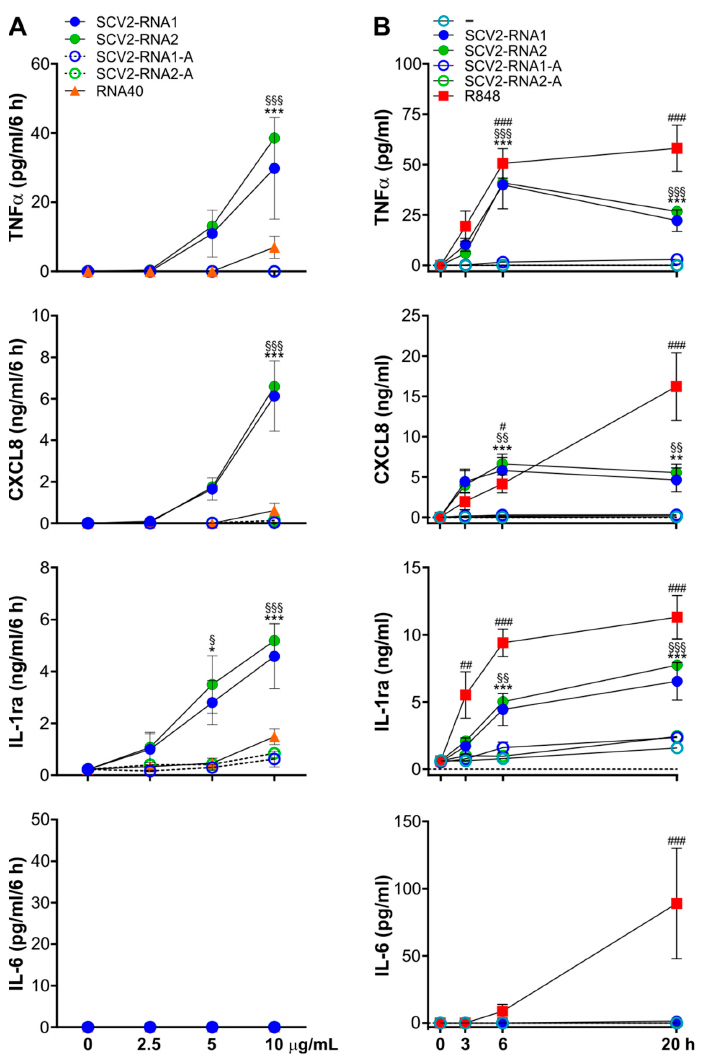
Figure 1. Cytokines production in neutrophils stimulated by SCV2-RNA1 and SCV2-RNA2. Pro- duction of TNF α , CXCL8, IL-1ra, and IL-6, by ssRNA-stimulated neutrophils in ( A ) dose-response and ( B ) time course experiments. In ( A ) neutrophils were stimulated for six hours with 2.5, 5 and 10 μ g/mL of SCV2-RNA1, SCV2-RNA1-A, SCV2-RNA2, SCV2-RNA2-A, and RNA40. In ( B ) neutro- phils were stimulated for three, six, and 20 h with 5 μ M R848 and 10 μ g/mL of SCV2-RNA1, SCV2- RNA1-A, SCV2-RNA2 and SCV2-RNA2-A. ( A , B ) Supernatants were collected, and cytokines levels were measured by ELISA. Results are expressed as the mean value ± SEM of n = 3–14 independent experiments. */§/# p < 0.05, **/§§/## p < 0.01, ***/§§§/### p < 0.001 by two-way ANOVA corrected for Tukey ( A ) or Dunnett’s ( B ) multiple comparisons test. § symbol indicates statistically significant differences between SCV2-RNA1 and SCV2-RNA1-A ( A ) or unstimulated cells ( B ), * symbol indi- cates statistically significant differences between SCV2-RNA2 and SCV2-RNA2-A ( A ) or